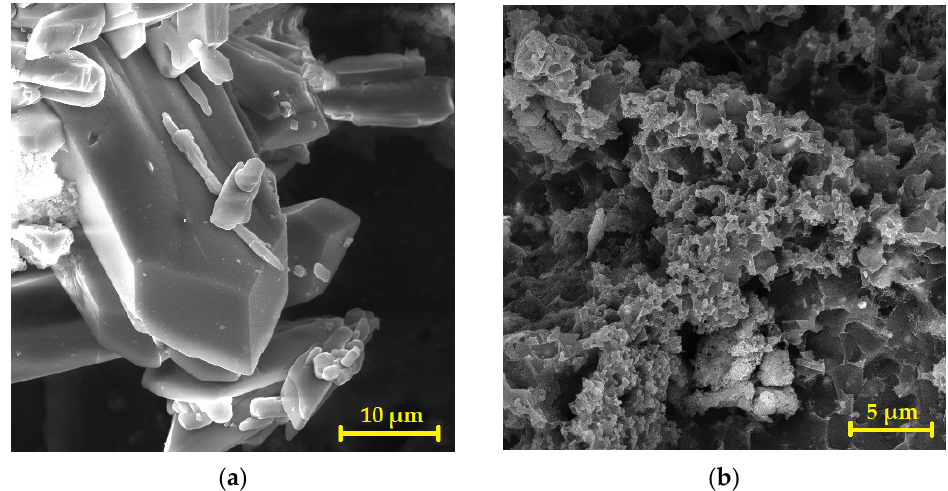
Figure 15. SEM photomicrographs of the coating after exposure to 30% CH 2 O 2 for 120 days: ( a ) NBR- CW containing shards exposed to the aggressive environment—3000× magnification; ( b ) NBR-REF with rounded particles—5000× magnification.